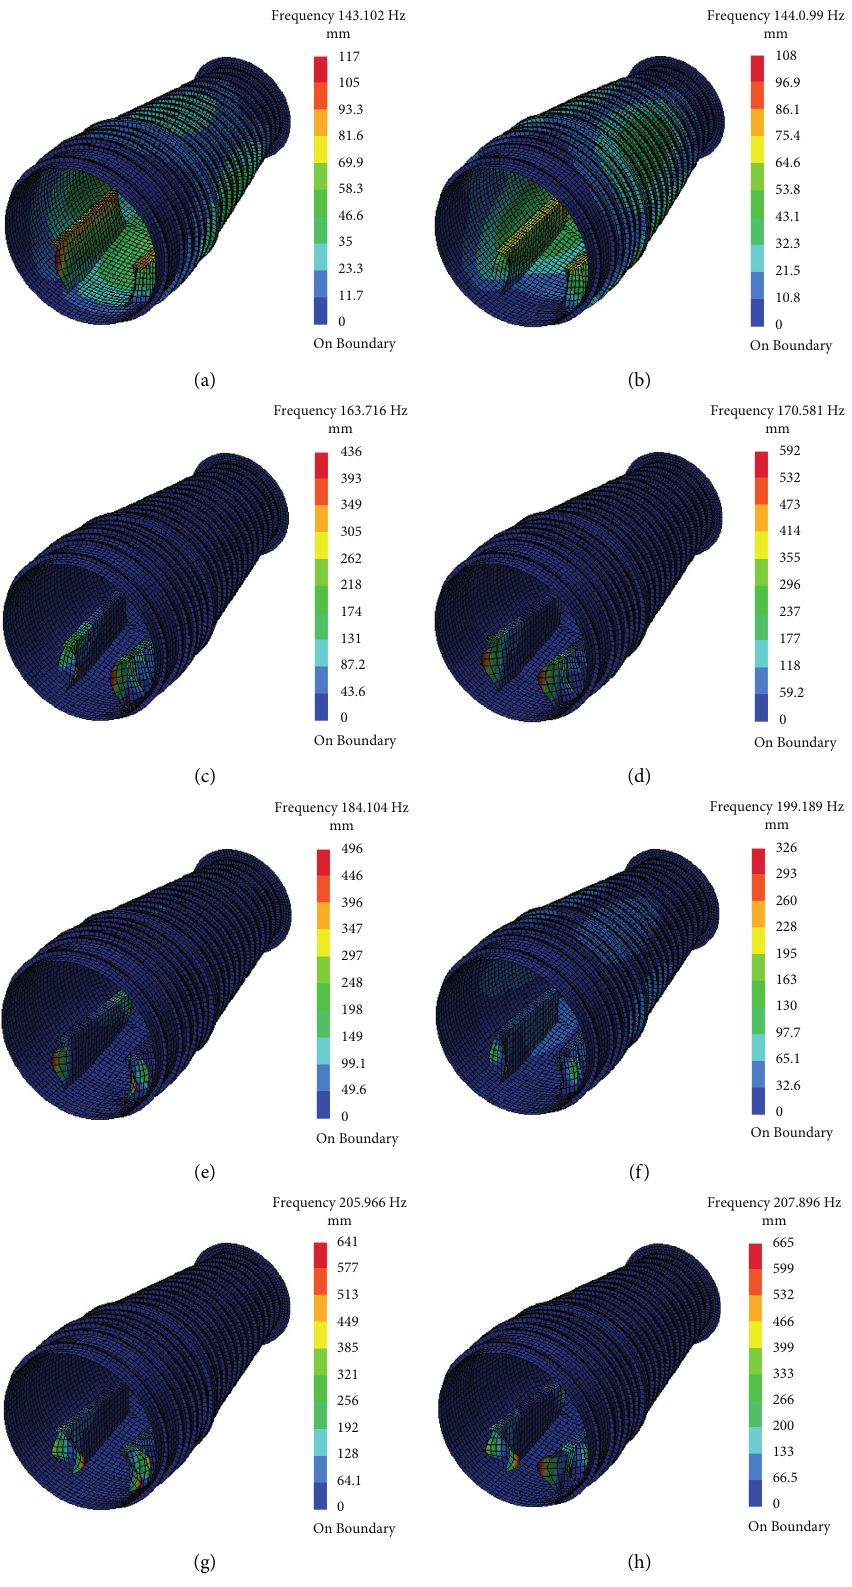
Figure 3: Modal shape of the ring-stiffened conical shell in vacuum. (a) The 1st order. (b) The 2nd order. (c) The 3rd order. (d) The 4th order. (e) The 5th order. (f) The 6th order. (g) The 7th order. (h) The 8th